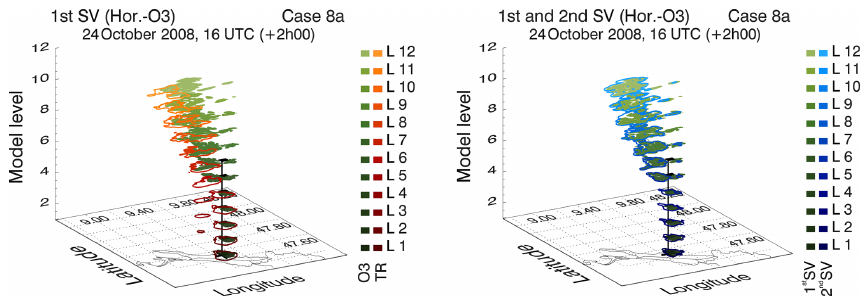
Figure 4. Horizontal placement of the first and second singular vectors with respect to initial value uncertainties for case 8a. Left panel: 0.01 isopleths of the first horizontal singular vector for passive tracer (red framed shading) and ozone (green filled shading). Right panel: 0.01 isopleths of the first (green filled shading) and second (blue framed shading) horizontal singular vectors for ozone. In both figures, the final profile VP( t F ) is marked with a black line and the black cross indicates its horizontal position. Case numbers and simulation intervals are given on top of each panel.